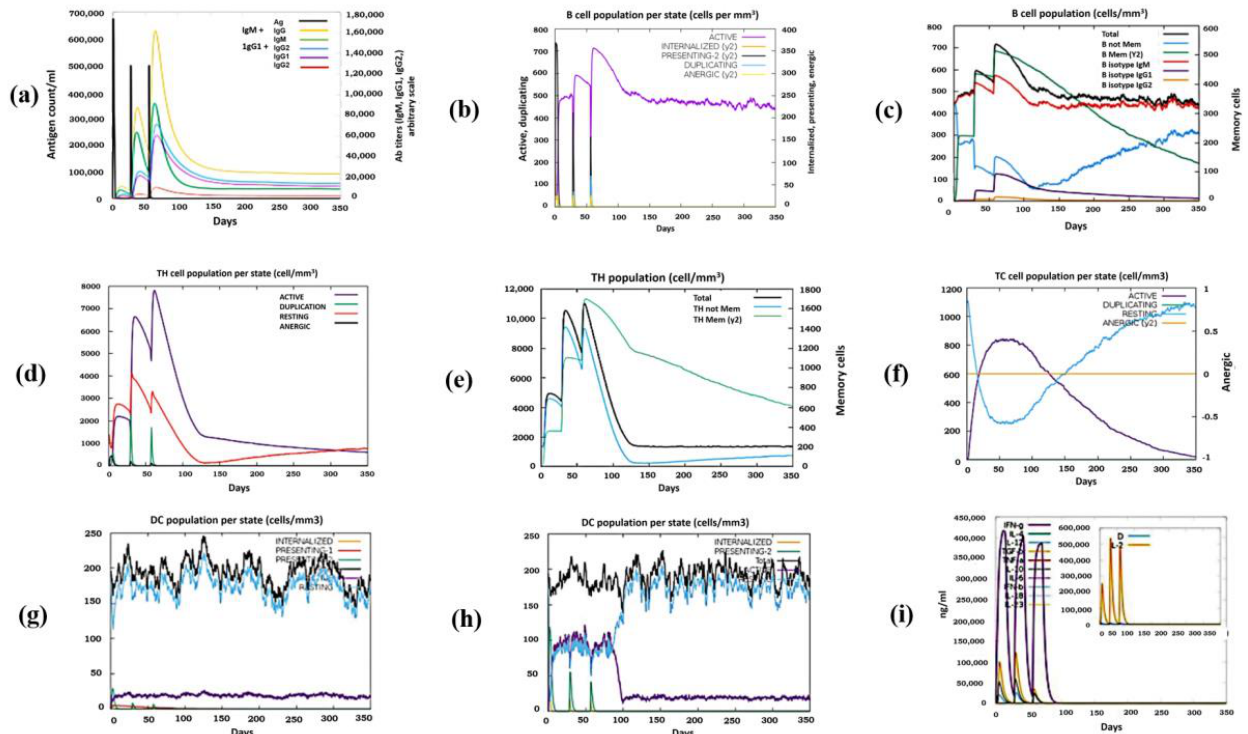
Figure 6. Immune simulation of peptide vaccine construct in three injections by C-immsim server. ( a ) Primary Antibody responses. ( b ) Active B-cells profile ( c ) Memory B-cells profile. ( d ) Active Helper T-cells profile. ( e ) Memory Helper T-cells profile. ( f ) Active Cytotoxic T-cells profile. ( g ) Dendritic cells profile. ( h ) Macrophages response profile. ( i ) Interleukins and cytokines profile.